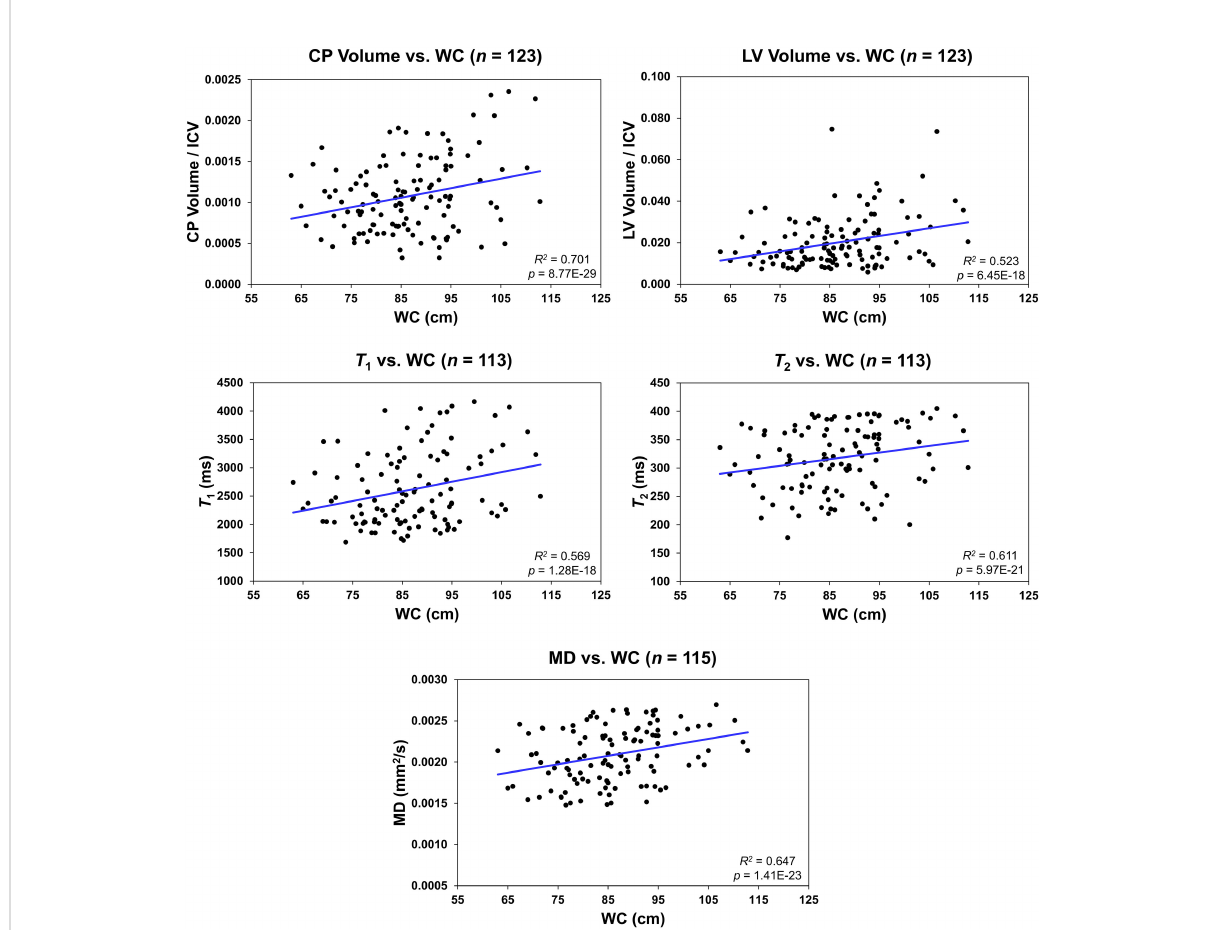
FIGURE 4 Regression results for the relationship between the lateral ventricle (LV) volume/intracranial volume (ICV), T 1 , T 2 , or mean diffusivity (MD) and waist circumference (WC) adjusted for age, age 2 , sex, and ethnicity. For the choroid plexus (CP) volume/ICV, regression results were controlled for age, age 2 , sex, ethnicity, and LV volume. The coef fi cient of determination, R 2 , and p-value, p , of the multiple linear regression model are reported. The CP volume, LV volume, T 1 , T 2 , or MD exhibited signi fi cant positive correlations with